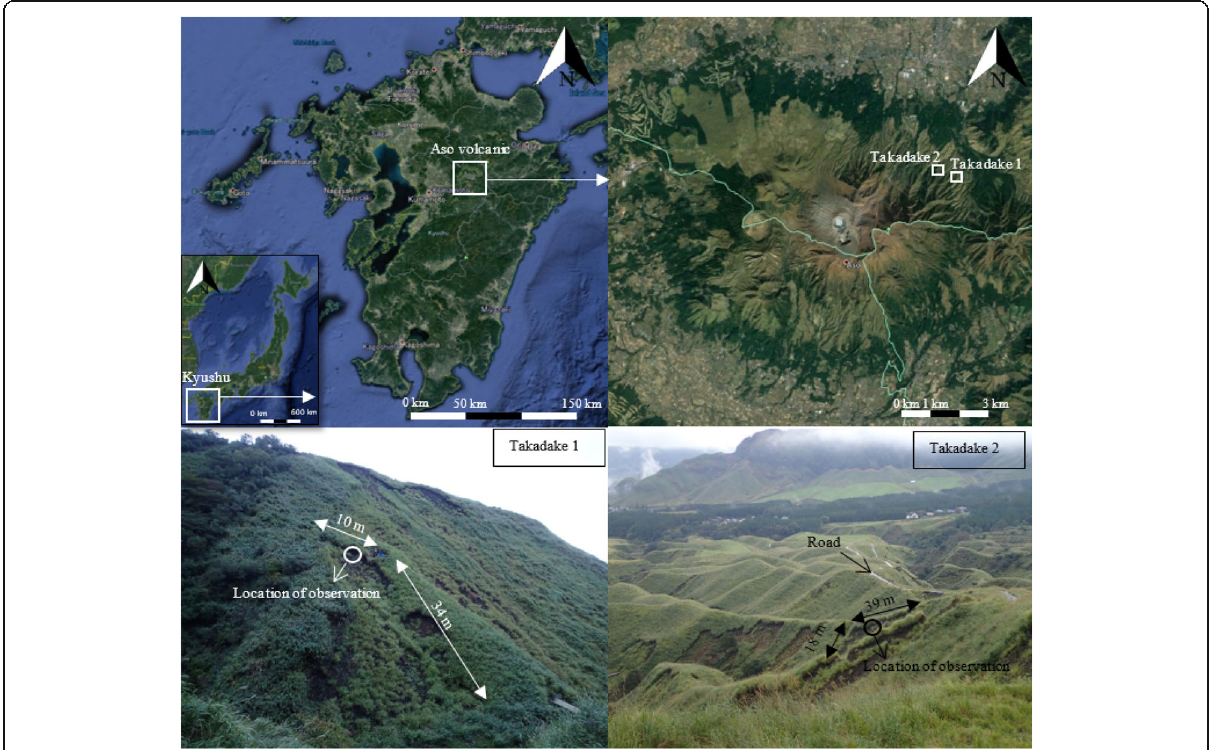
Fig. 1 Shallow landslides in Aso mountains (Photos taken on October 2016) (Scale measured by geolocation